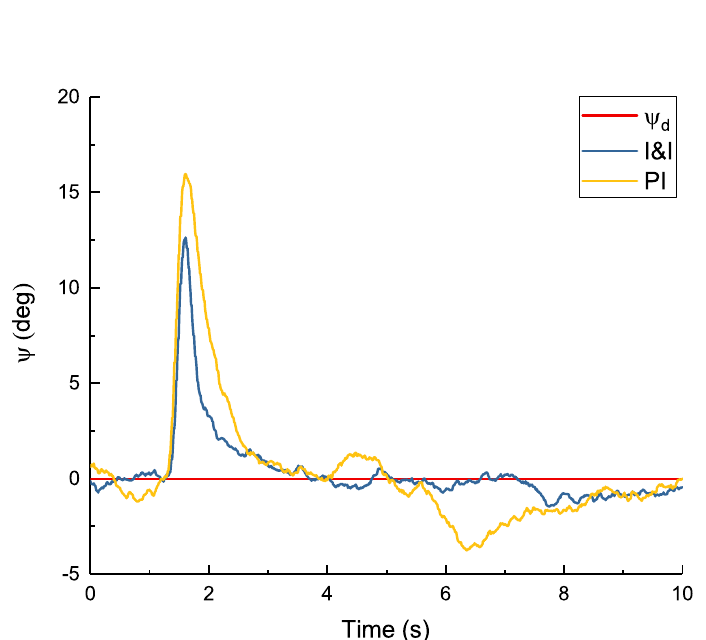
Figure 10. Yaw Control Comparison between I&I and PI